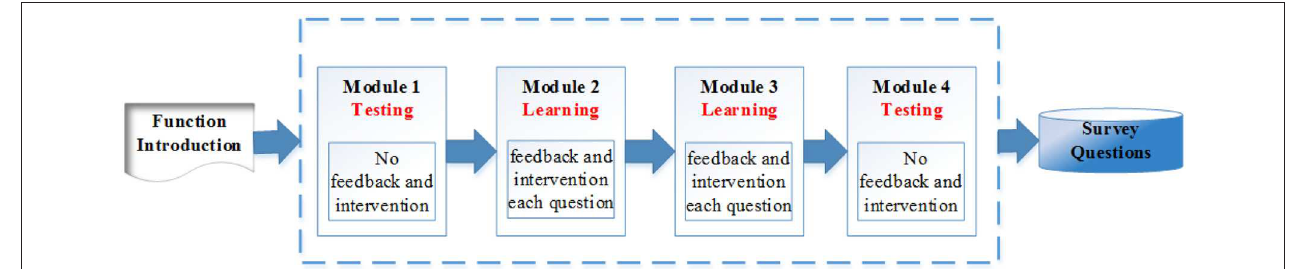
FIGURE 1 | Spatial rotation learning program